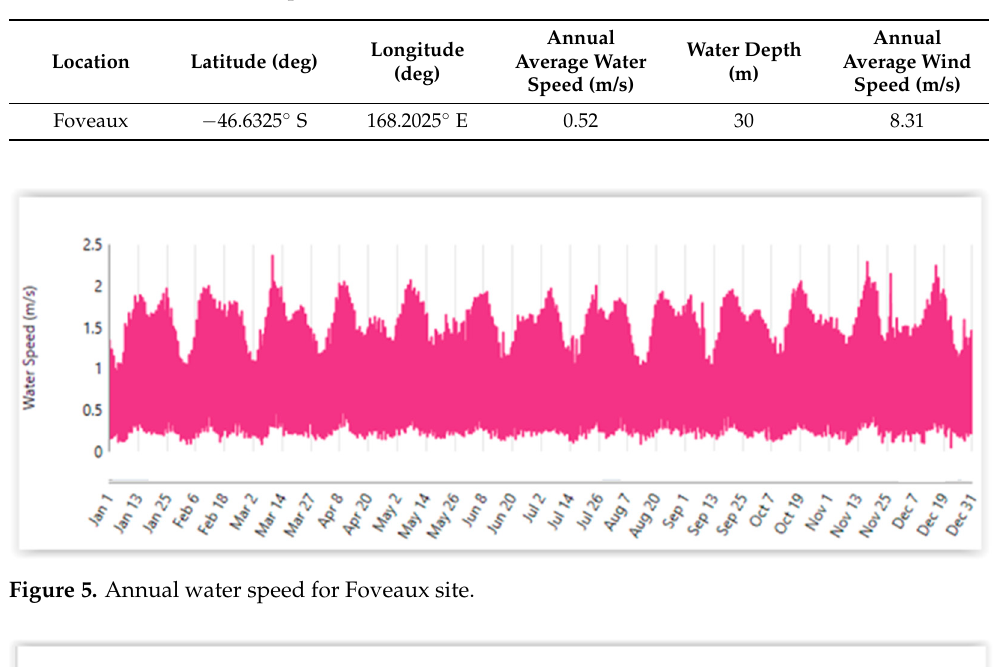
Figure 7. A DC bus connects all the components.